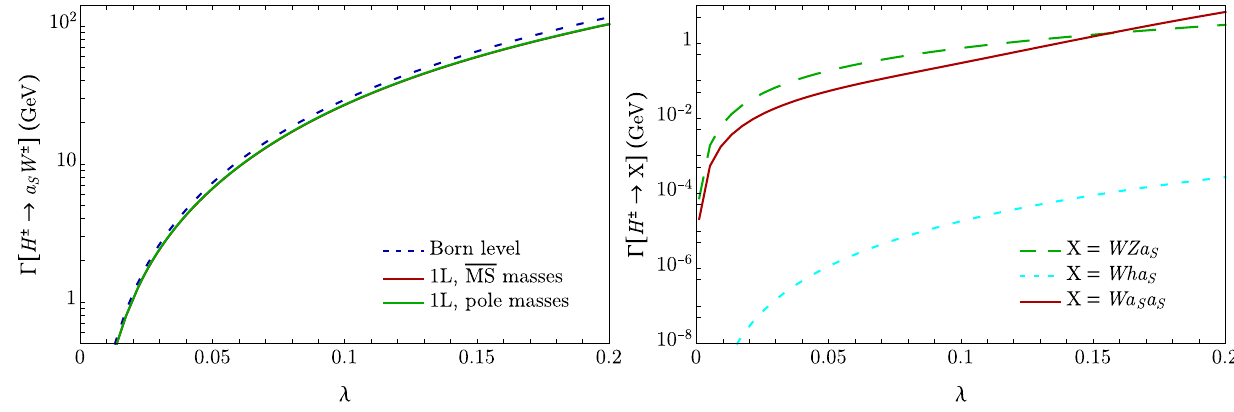
Fig. 9 BosonicHiggsdecaysofthechargedHiggsintheNMSSMsce- nario of Sect. 3. Left : the two-body width (cid:6) [ H ± → a S W ± ] is shown at tree-level (dashed blue) and at 1L for two choices of schemes for